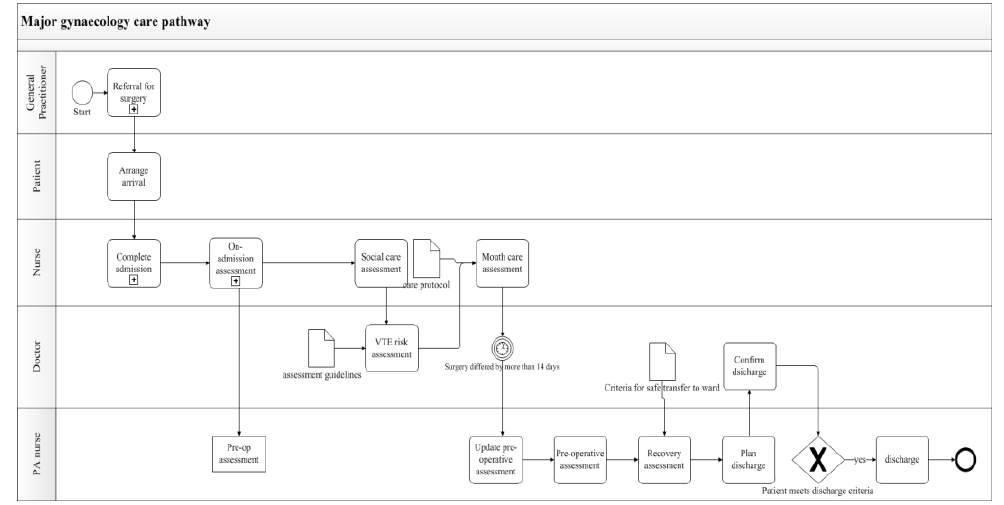
Figure 2. Part of CP for major gynecology